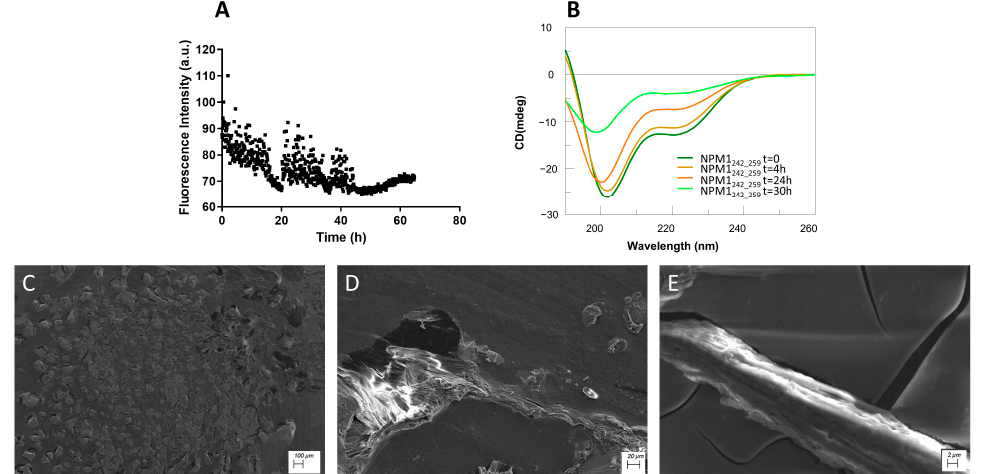
Figure 7. NPM1 242–259 characterization: ( A ) Time course of ThT fluorescence emission intensity; ( B ) CD spectra over time; ( C – E ) SEM micrographs registered at 24 h at 100, 20 and 2 µm.